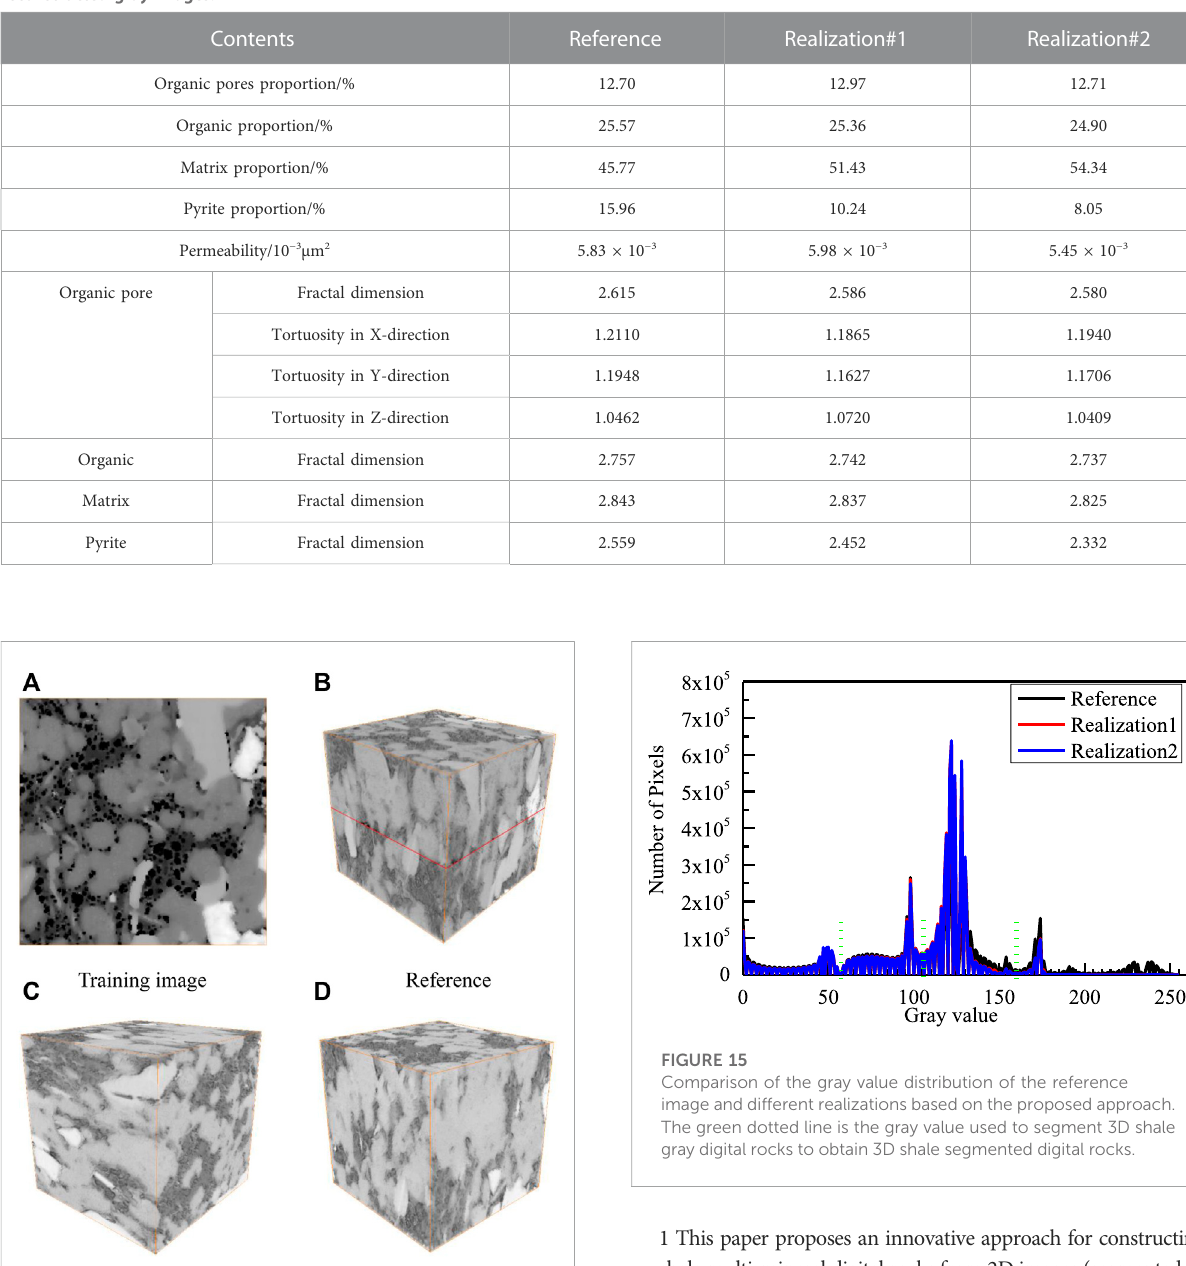
TABLE 4 Petrophysical properties and pore structure parameters of the training image and two realizations were obtained through segmentation of the reconstructed gray images.